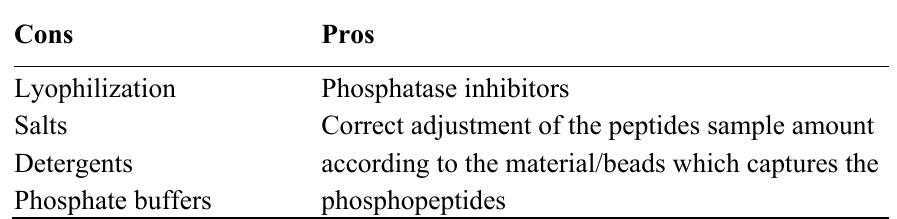
Table 4. Critical events during sample preparation prior analyses of phosphorylated proteins via proteomics and mass